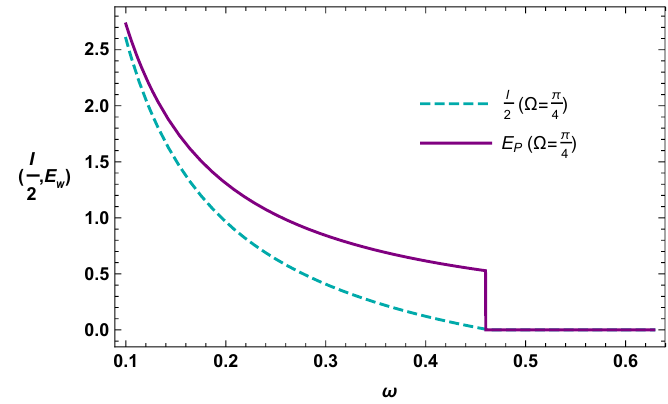
Figure 10 . EWCS (HMI) as a function of ! in d = 3 that undergoes a discontinuous (continuous) phase transition beyond which it is identically zero. Here we normalize these quantites by a factor of 2 G N (cid:15)=H